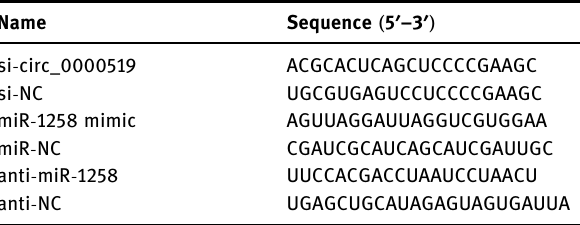
Table 1: The oligo sequences for transfection in this study